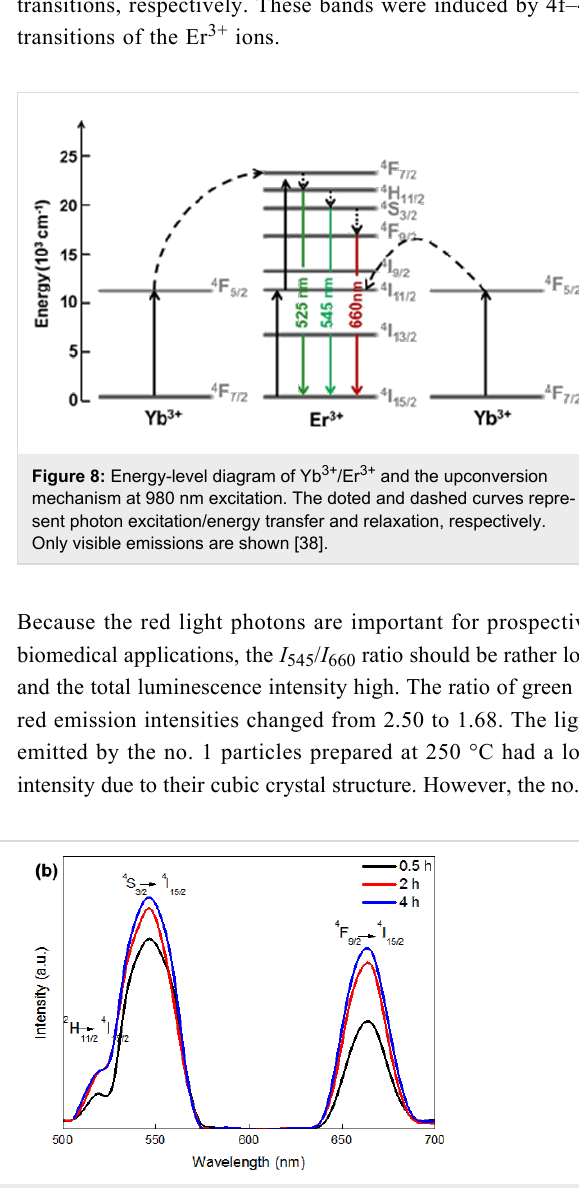
Figure 7: NIR-to-vis upconversion emission spectra of OM–NaYF 4 :Yb 3+ /Er 3+ nanoparticles excited at 980 nm with a power density of 3 mW/cm 2 . Effect of (a) reaction temperature and (b) time.